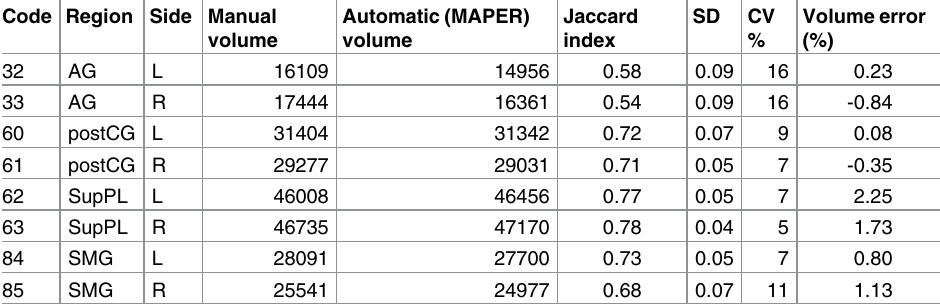
Automatically generated labels were compared with manually drawn labels by overlap and volume.